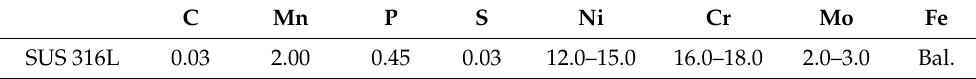
Table 1. Chemical composition of stainless steel 316L [32].